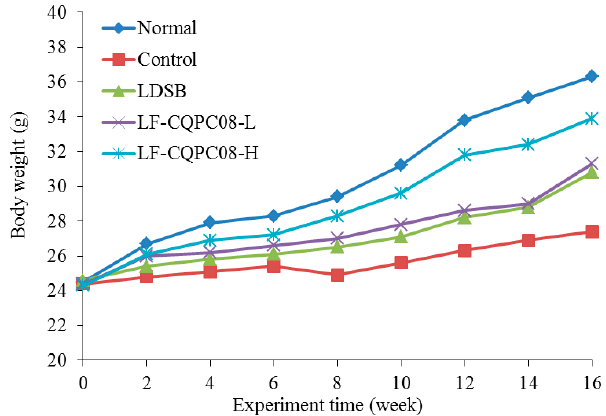
Figure 1. Body weight of mice during the experiment. LDSB: mice treated with 4NQO and Lactobacillus delbruechii subsp. bulgaricus (1.0 × 10 9 CFU/kg); LF-CQPC08-L: mice treated with 4NQO and Lactobacillus fermentum CQPC08 (1.0 × 10 8 CFU/kg); LF-CQPC08-H: mice treated with 4NQO and